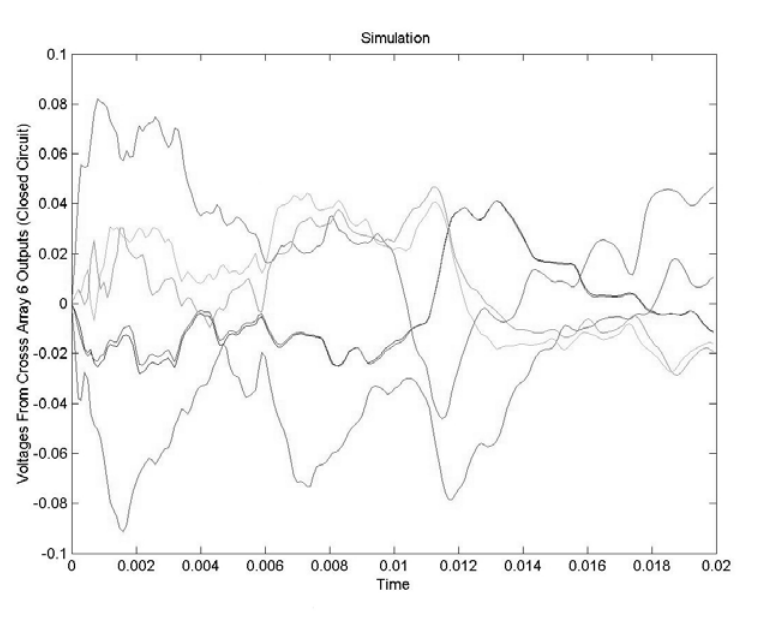
Fig. 17. Simulation scaled response of the Cross. Array (6 outputs), center